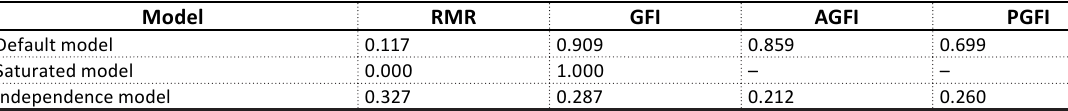
Table 5. Details of GFI and other